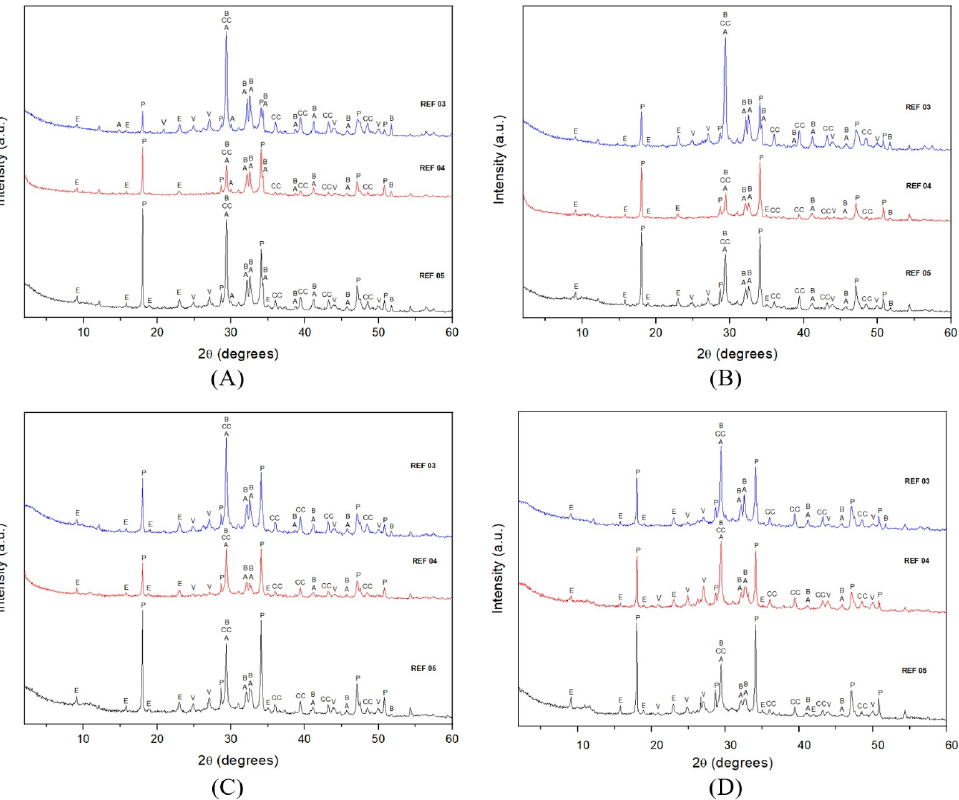
Figure 6. Diffractograms of the cement pastes without supplementary cementitious materials (SCMs), with 1 day (A), 3 days (B), 7 days (C), and 28 days (D) of hydration. E- ettringite, P-portlandite, V-vaterite, A-alite, CC-calcite,